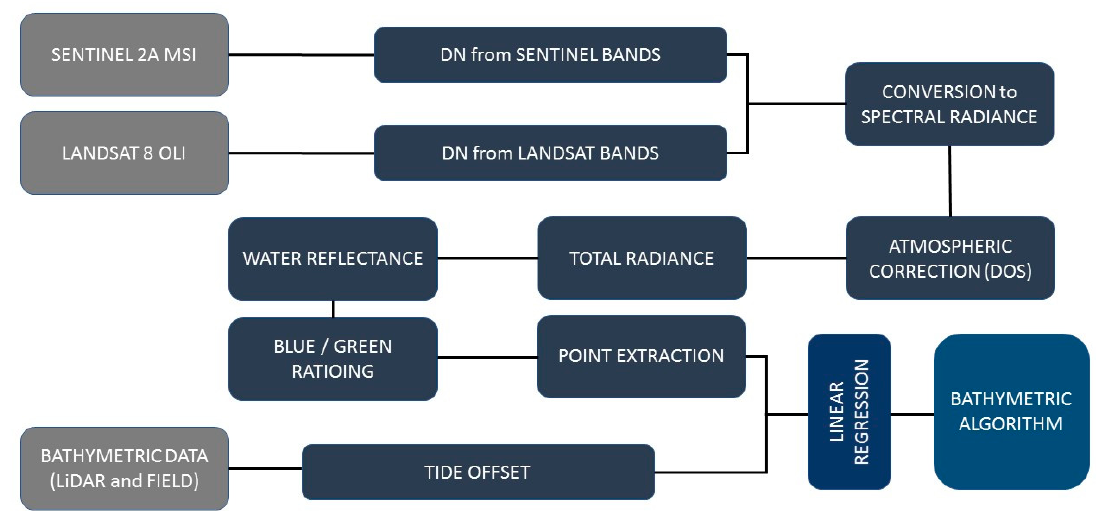
Figure 2. Flowchart for deriving bathymetric maps from Sentinel-2 and Landsat-8 images using empirical models.